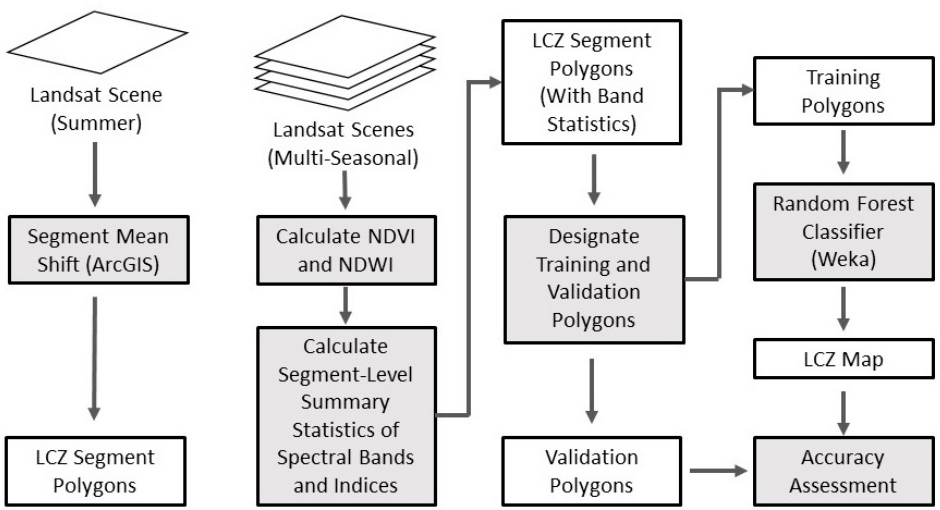
Figure 2. Outline of the main analysis workflow.